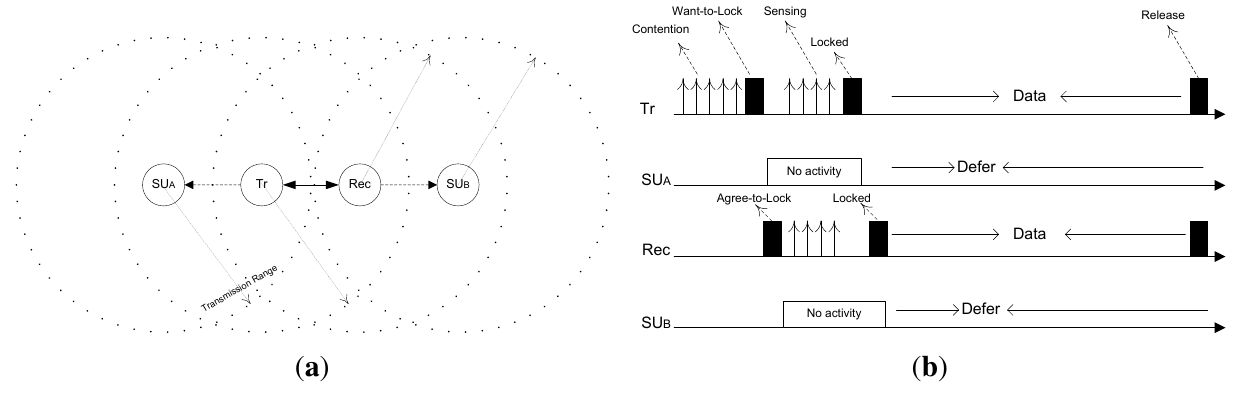
Figure 7. PU activity-aware distributed (PAD)-MAC protocol architecture. ( a ) SU communication ranges; ( b ) PAD-MAC channel reservation and data transmission